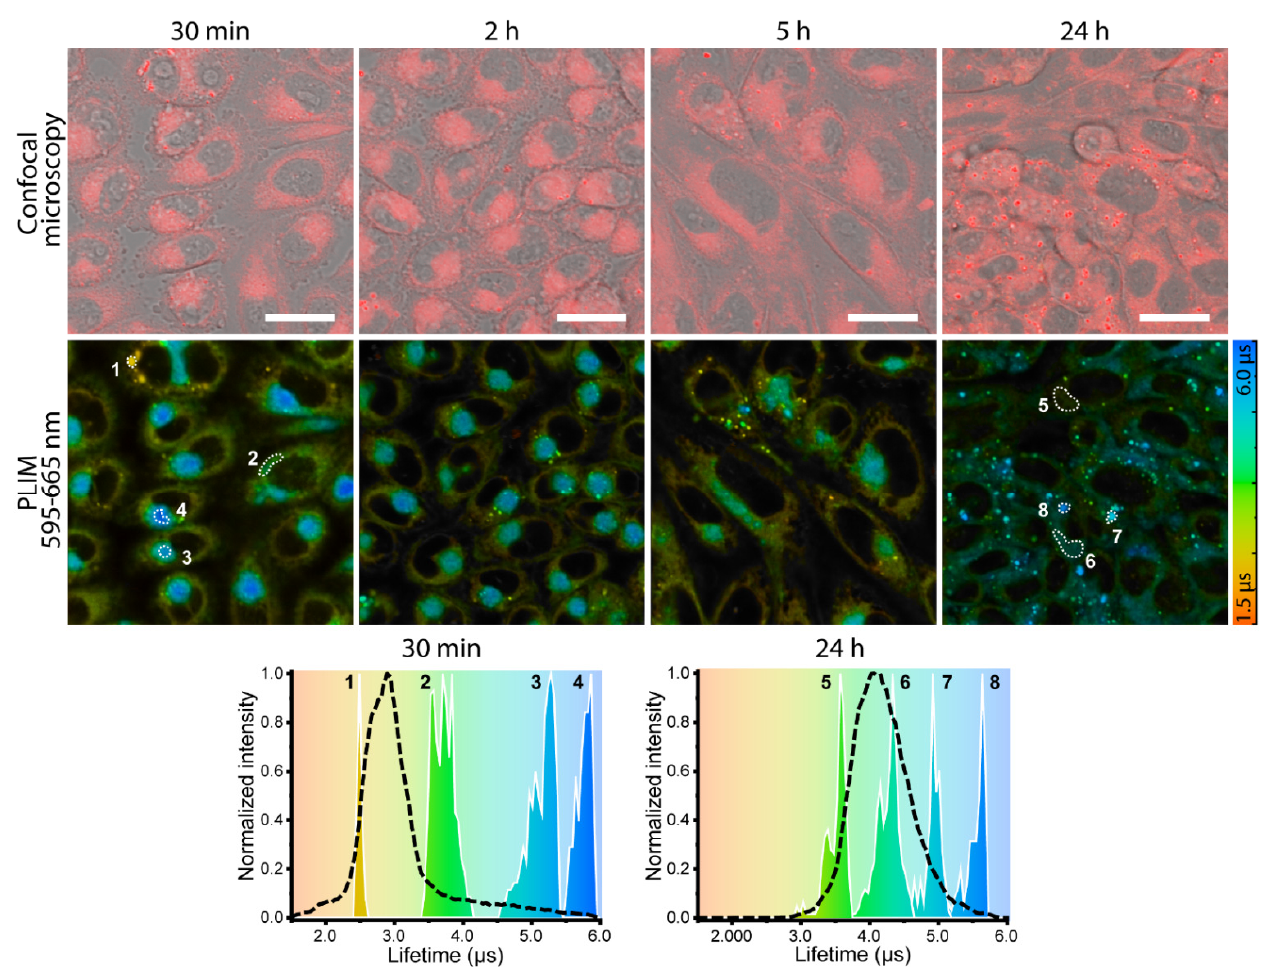
Figure 6. Confocal/DIC (top row) and PLIM (middle row) microphotographs of HCO-K1 cells incubated with 0.3 mg/mL Pt1@PCL- b -PEG (12.1 wt.% Pt1 ) for 30 min, 2, 5, and 24 h under normoxia at 37 ° C. Bottom row: lifetime distributions of the selected areas (1–8) after 30 min (left) and 24 h (right) incubation overlaid with the lifetime distributions across the image (black dashed lines). Excitation: 405 nm; Detection: 663–738 nm (confocal microscopy, top row); 595–665 nm (PLIM; middle row). Scale bar: 20 μ m.